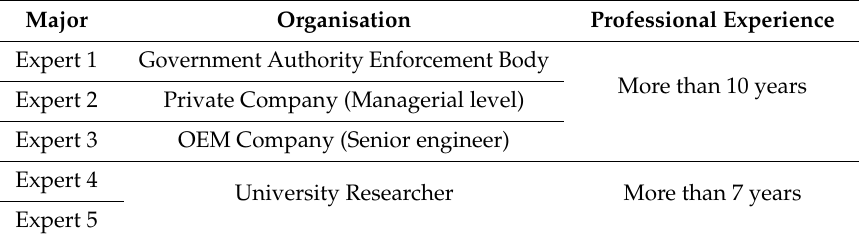
Table 3. Respondents